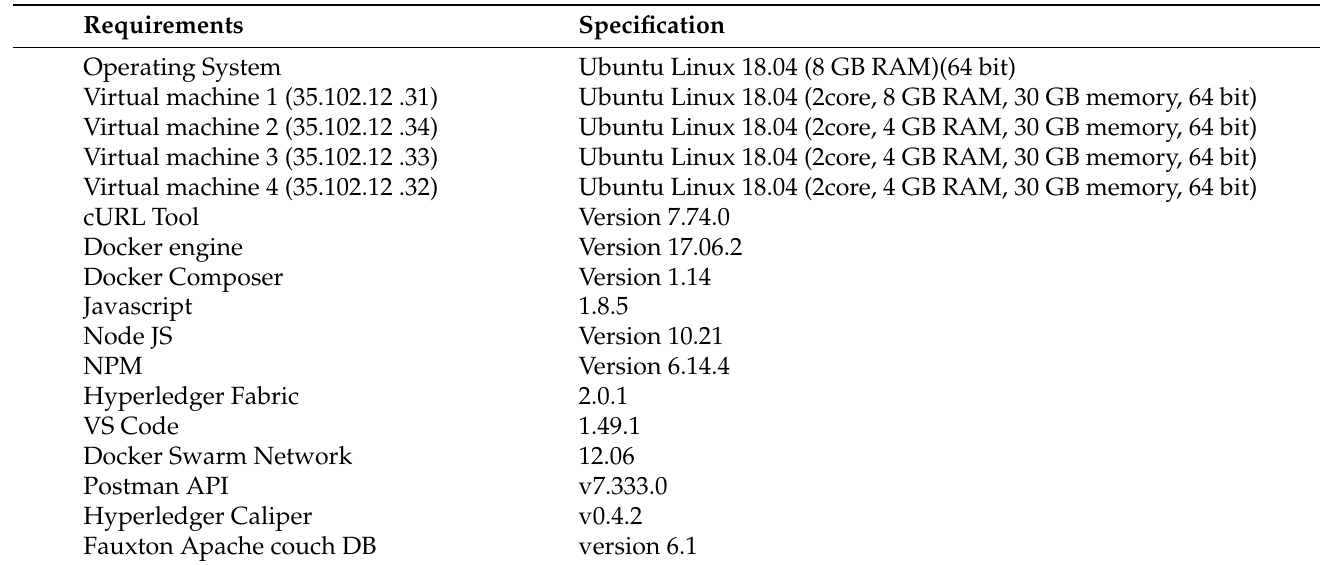
Table 2. Requirements and specification of proposed EHR Blockchain